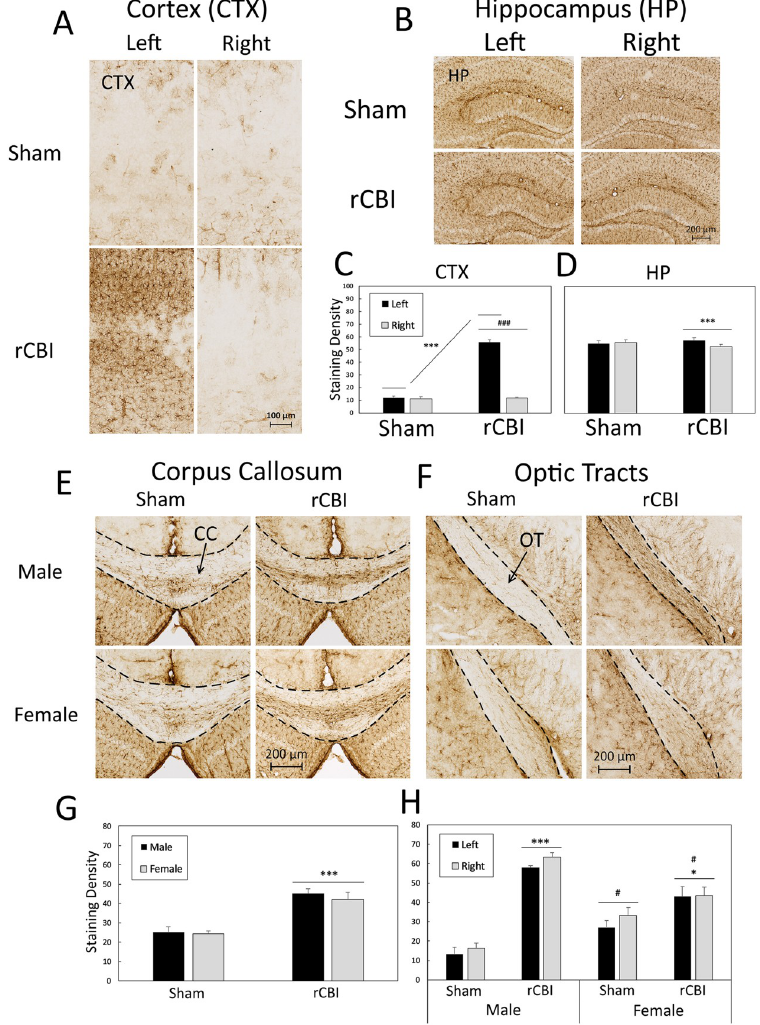
Fig 4. Astrogliosis as observed by GFAP staining following repetitive concussive brain injury (rCBI). All sections shown represent the approximate median value from each group. No sex differences were found in the cortex (CTX; A & C ) or hippocampus (HP; B & D (dentate gyrus, CA1 and CA2/3 regions averaged)) and data are collapsed by sex. GFAP staining was increased on the injured (left) side of the CTX in all mice that sustained rCBI ( A & C ; ��� , rCBI > Sham, p < 0.0001). The uninjured side of the brain did not show signs of increased astrogliosis, having significantly reduced staining density compared to the injured side (###, rCBI > Sham, p < 0.0001). In the HP, injured mice and sham-treated mice had similar levels of GFAP staining density ( B & D ). In injured mice, however, staining density was higher on the injured (left) side of the brain than on the uninjured side ( ��� , rCBI Left > rCBI Right, p < 0.0001). rCBI increased astrogliosis in white matter tracts ( E-H ). The corpus callosum had significantly increased GFAP staining density following rCBI ( E & G , ��� , rCBI > Sham, p < 0.0001). Astrogliosis was also increased in the optic tracts in both male and female mice that sustained rCBI ( F & H ; F shows optic tracts from the left (injured) side of the brain), H: ��� , Male rCBI > Male Sham ( p < 0.0001); � , Female rCBI > Female Sham ( p < 0.05). Sex differences were observed in the optic tracts with males having higher levels of GFAP staining density than females (Male rCBI > Female rCBI; # ( p < 0.05), Male sham < Female Sham; # ( p < 0.05). GFAP, glial fibrillary acidic protein; rCBI, repetitive concussive brain